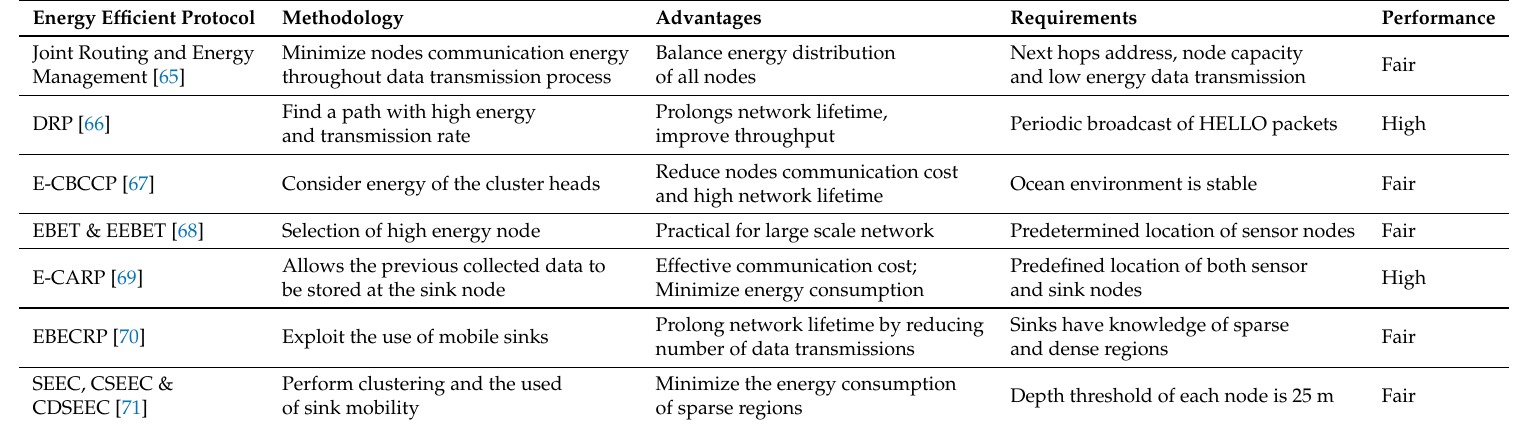
Table 5. List of Current Techniques for Energy Efficient Routing Protocols in UWSNs.